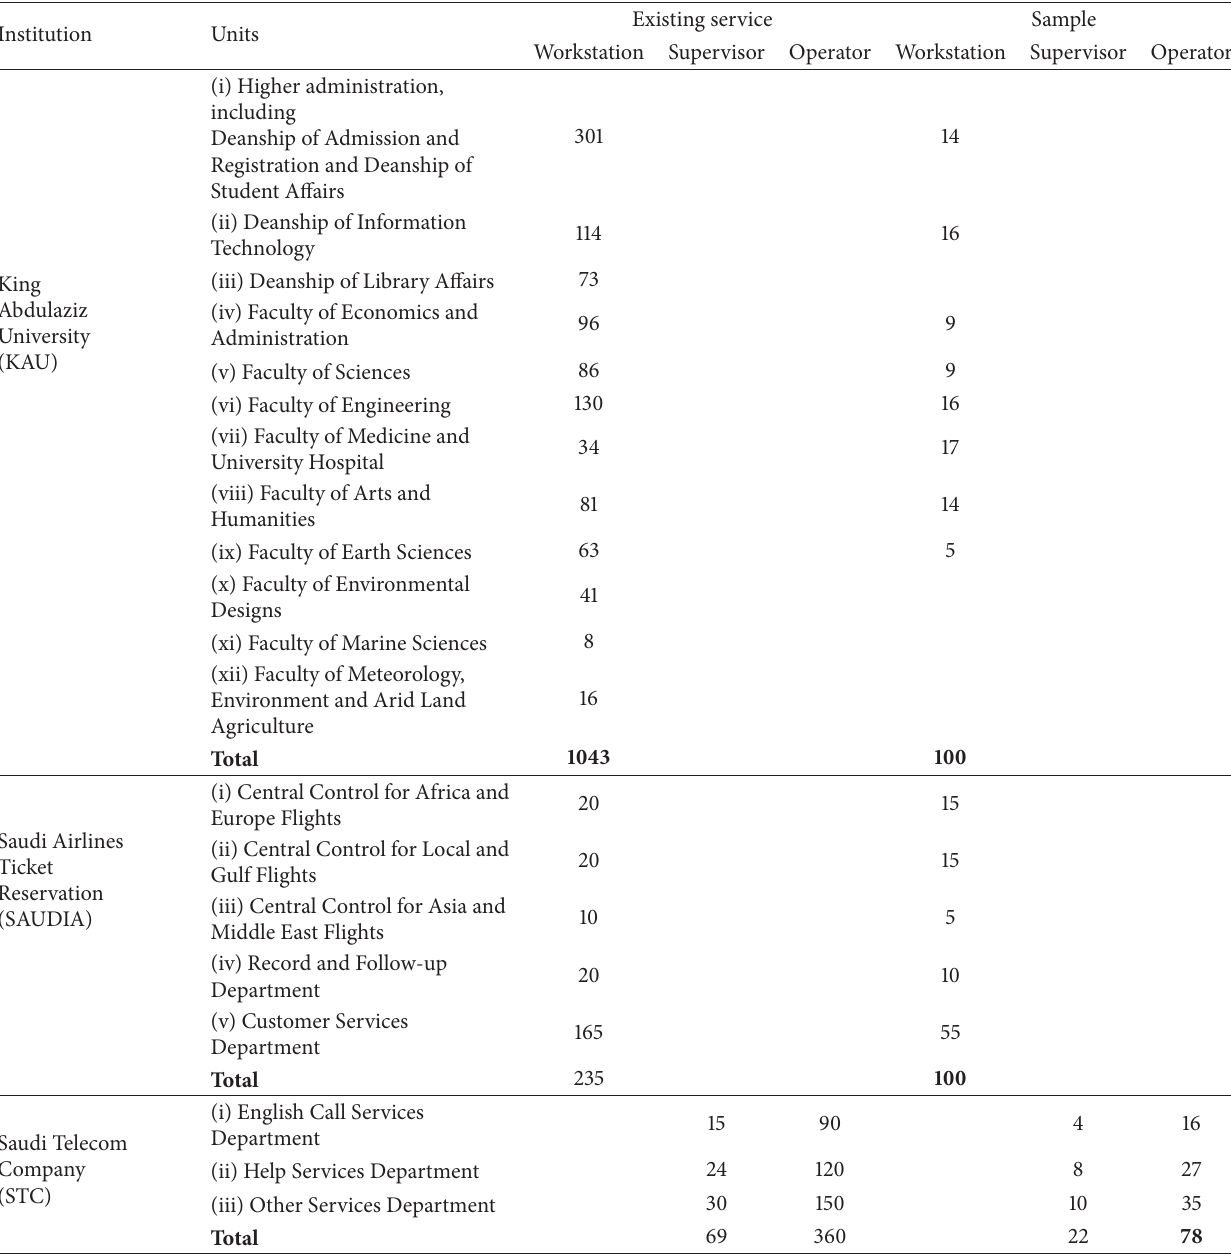
Table 1: Existing computer workstations and operators in the different units of KAU, SAUDIA, and STC and the sample selected for the study.